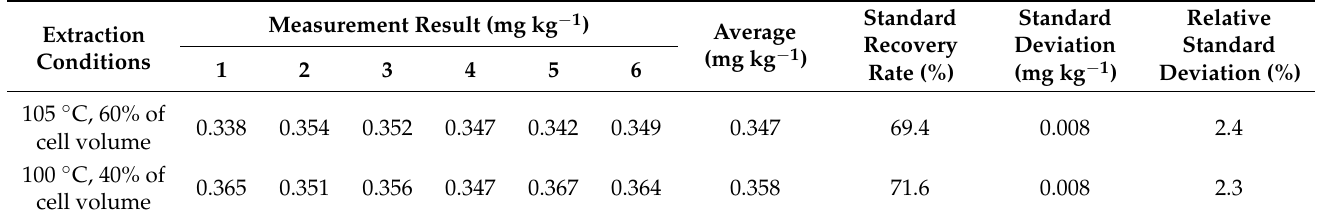
Table 1. The effect of ASE on the recovery rate of the aniline matrix spike. The spiked concentration of aniline in the soil was 0.5 mg kg − 1 , and the number of extractions was